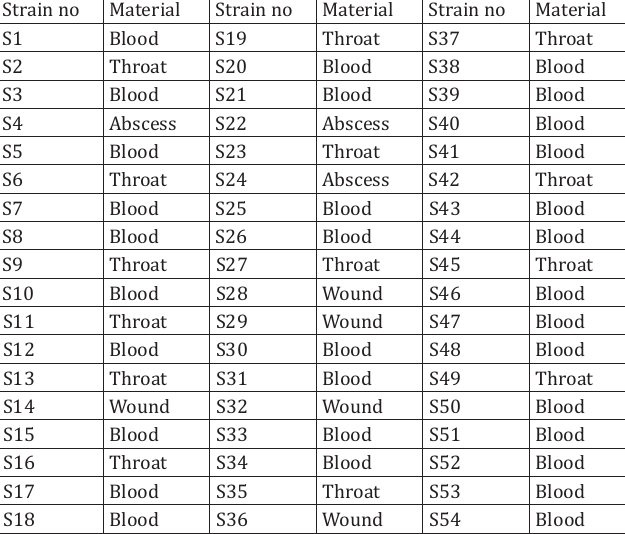
Distribution of SDSE samples according to the patient material.